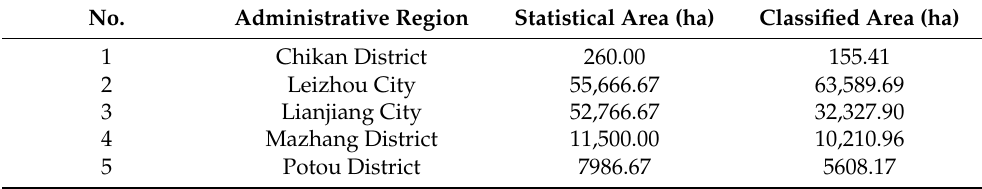
Table 3. Classified areas of rice in various districts and counties of Zhanjiang